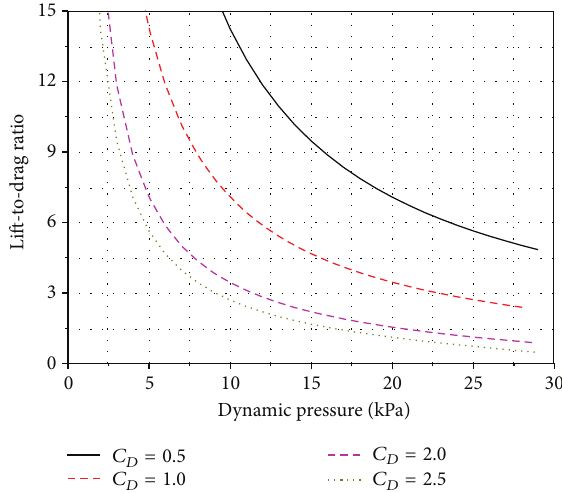
Figure 1: Relations between dynamic pressure and lift-to-drag ratio (𝐿/𝐷)